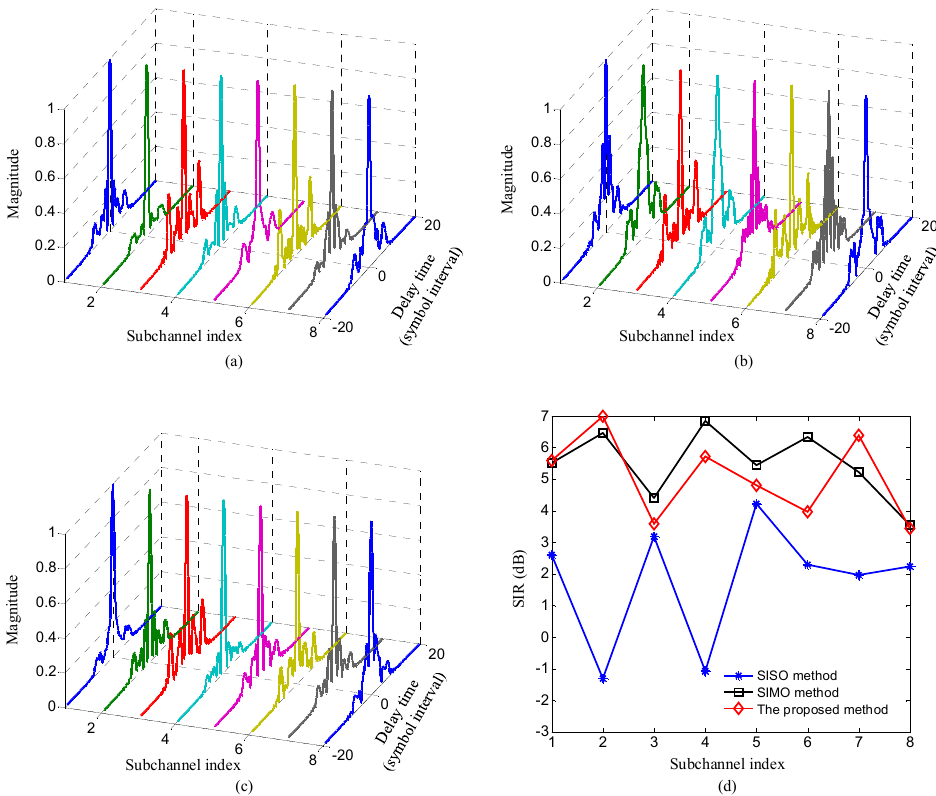
Figure 6. Comparison of the time domain responses and signal-to-interference ratios (SIRs) of composite sub-channels among three methods: ( a ) sub-channel responses of the proposed method; ( b ) sub-channel responses of SISO method; ( c ) sub-channel responses of SIMO method; ( d ) SIRs of three methods.